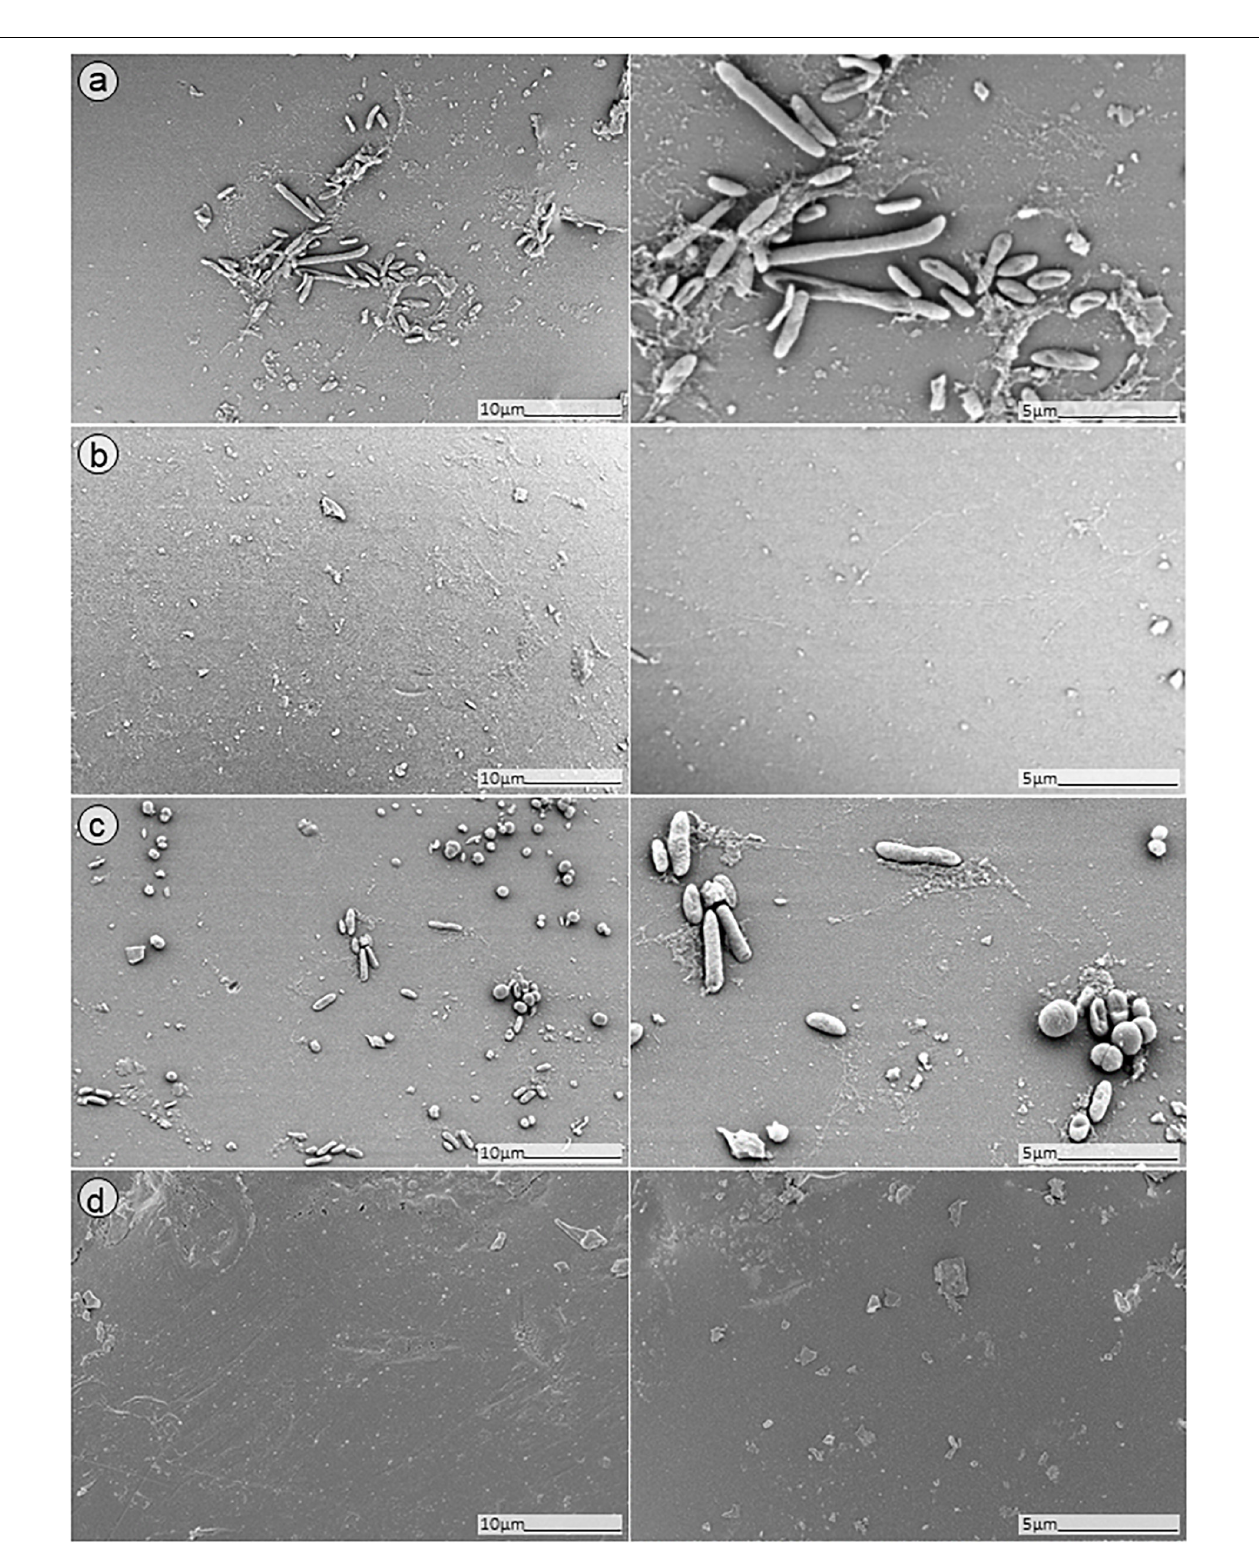
FIGURE 9 | SEM analysis of S. aureus/P. aeruginosa dual-species biofilm grown on porous glass beads for 24 h and treated with a combinatorial therapy of (a) simultaneous exposure to PYO and ciprofloxacin (1 mg/L, 24 h); (b) staggered exposure to PYO (12 h) followed by ciprofloxacin (1 mg/L, 24 h); (c) simultaneous exposure to PYO+Sb-1 and ciprofloxacin (1 mg/L, 24 h); or (d) staggered exposure to PYO+Sb-1 (12 h) followed by ciprofloxacin (1 mg/L, 24 h).